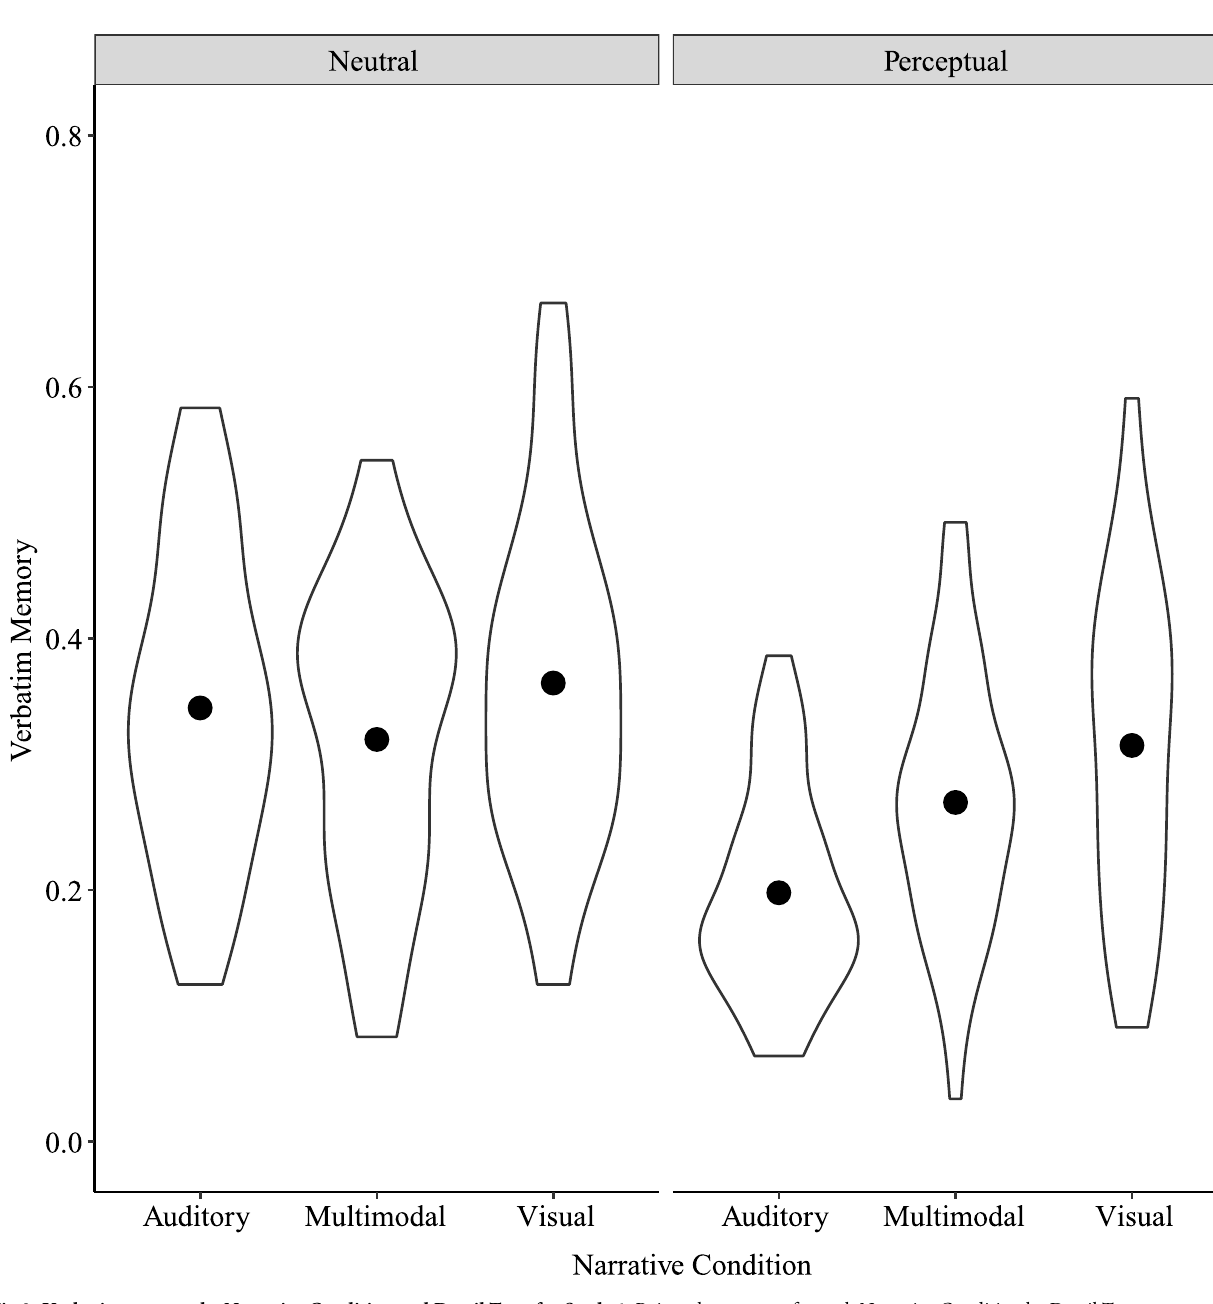
PLOS ONE | https://doi.org/10.1371/journal.pone.0249950 April 14,